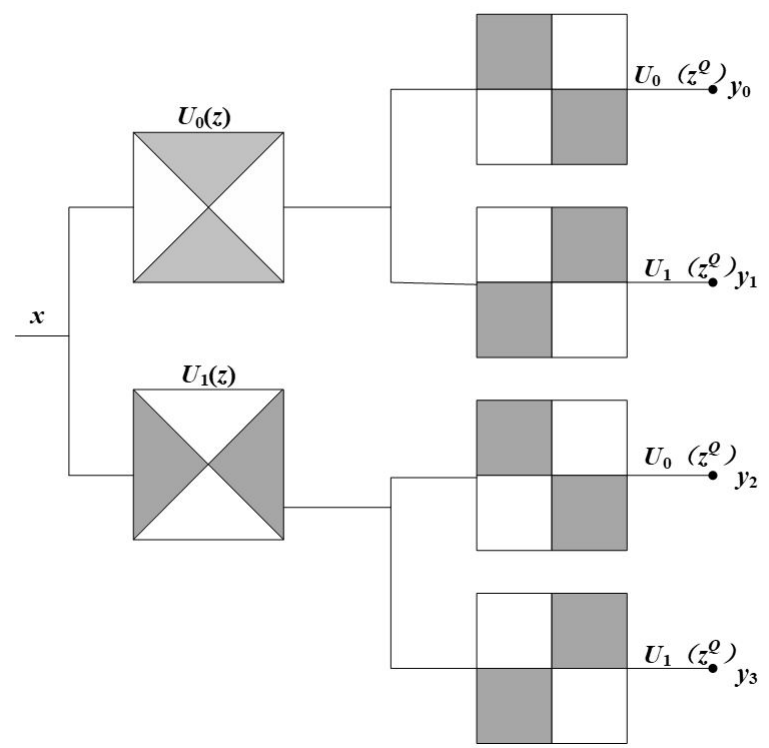
Figure 5. Schematic diagram of NSCT directional filter banks.